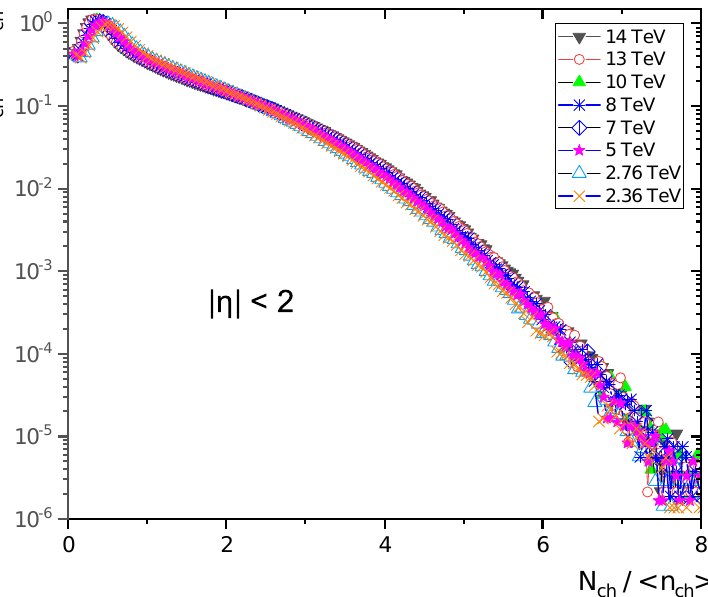
Figure 10. KNO form of charged particle multiplicity distribution at different energies in pseudora- pidity | η | <